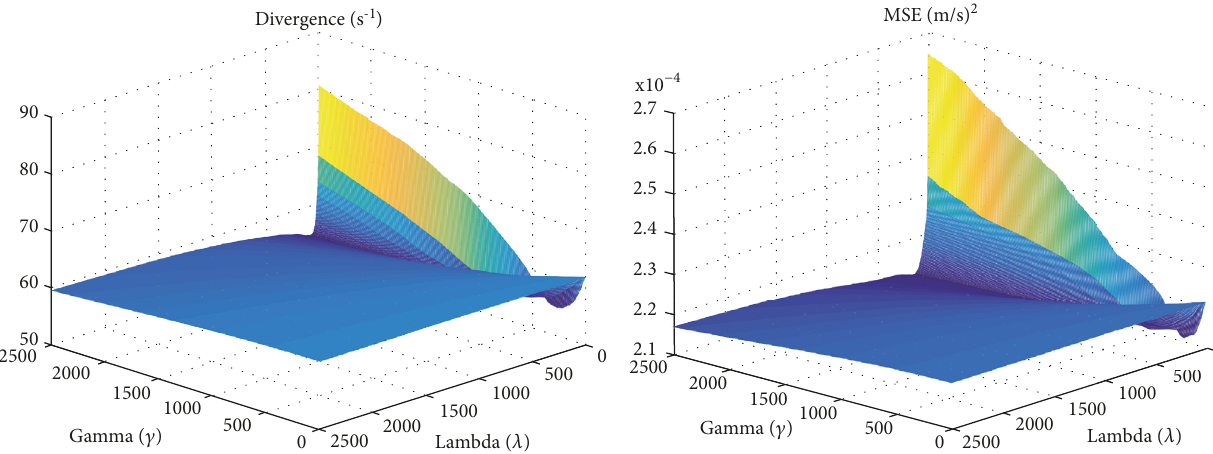
Figure 10: Divergence and MSE profiles of the proposed method as 𝛾 and 𝜆 are increased linearly from 0.1 to